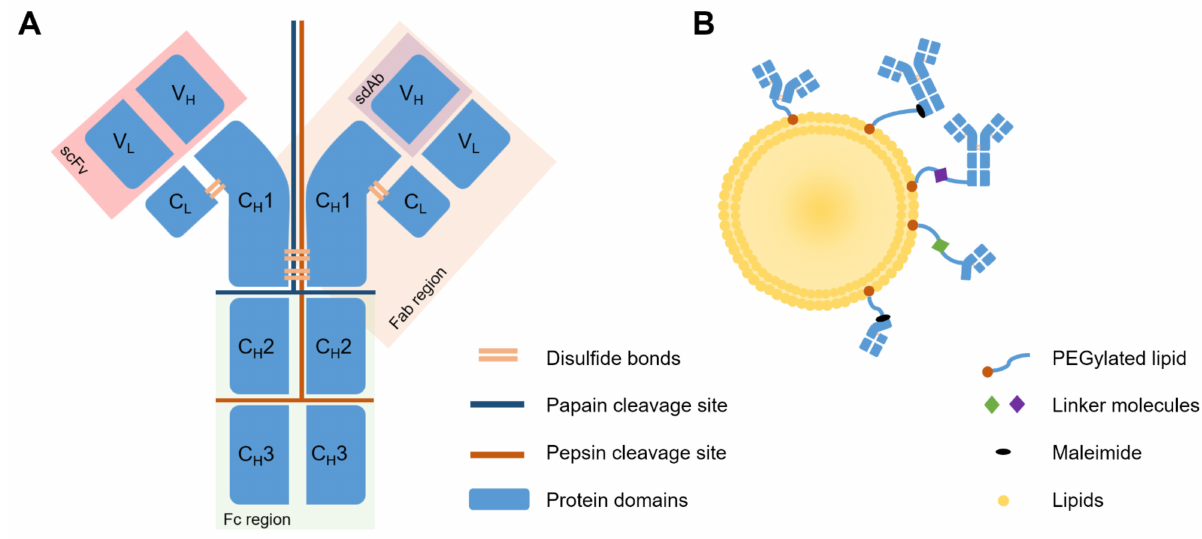
Figure 5. ( A ) Basic structure and enzymatic cleavage sites of a typical IgG antibody, with ( B ) conju- gation methods and schematic linking sites to liposomes. Abbreviations: Fc (fragment crystalline); Fab (fragment antigen-binding); C (conserved); V (variable); H (heavy); L (light); scFv